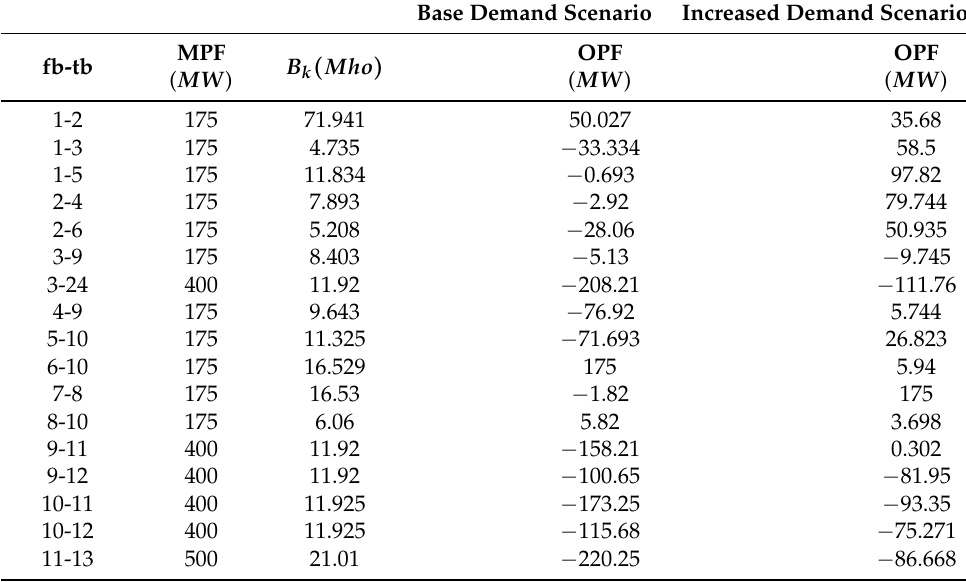
Table 13. The results of the optimal power flow of the 39-bus system with increase in